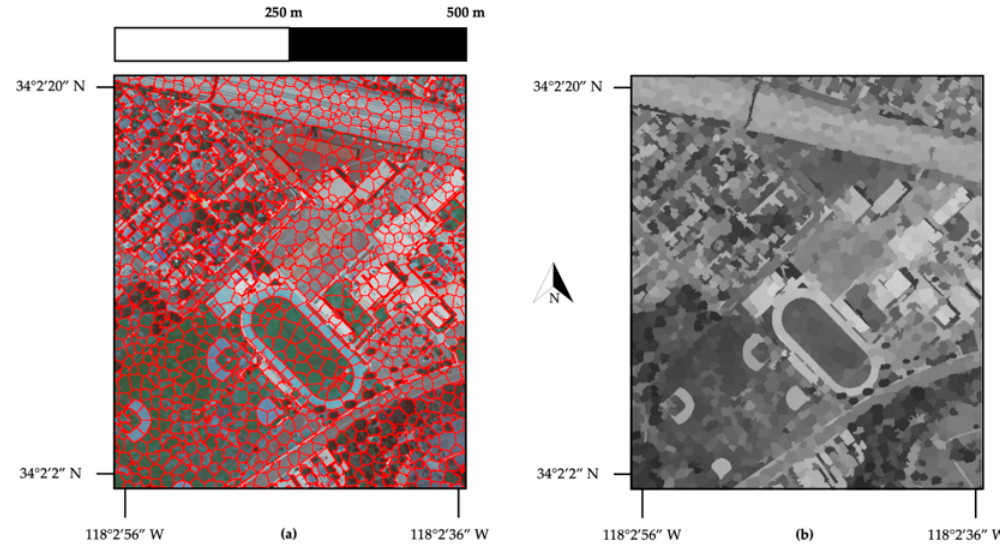
Figure 6. Object-based image classification significantly improves classification accuracy of high-resolution imagery in heterogeneous urban and suburban regions: ( a ) the SNIC algorithm identifies spectrally similar groups of neighboring pixels based on RGB values near South El Monte High School; ( b ) spectral and textural values within a single “superpixel” are averaged prior to being used for training data in a supervised learning